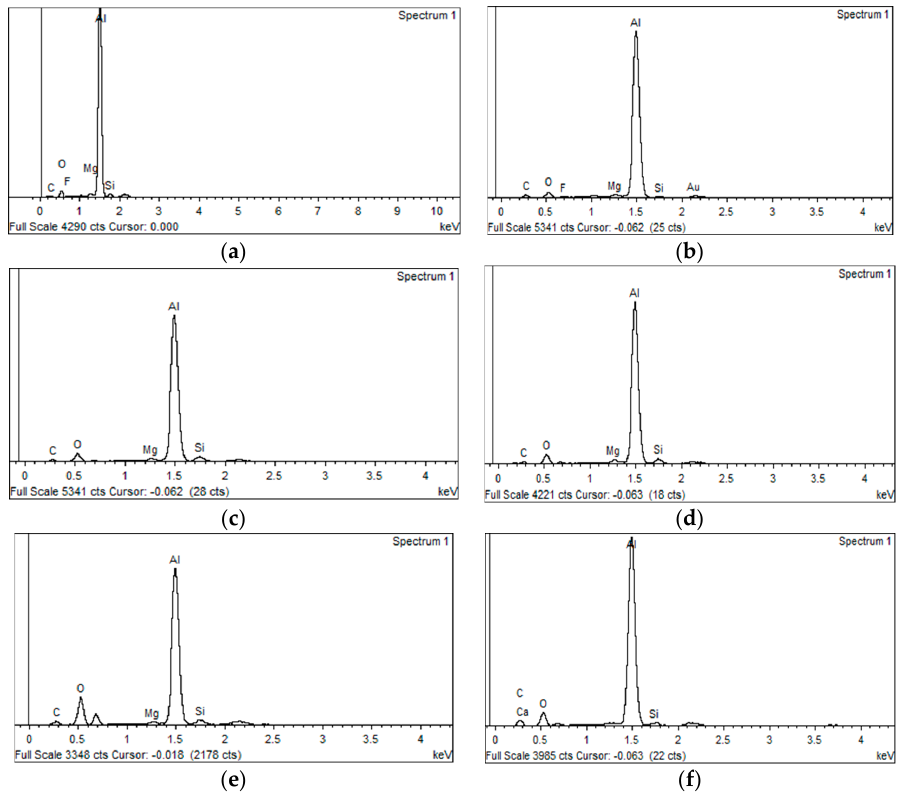
Figure 9. EDS images of the investigated: ( a ) Al/5% B 4 C − 5% ZrO 2 , ( b ) Al/15% B 4 C − 15% ZrO 2 , ( c )